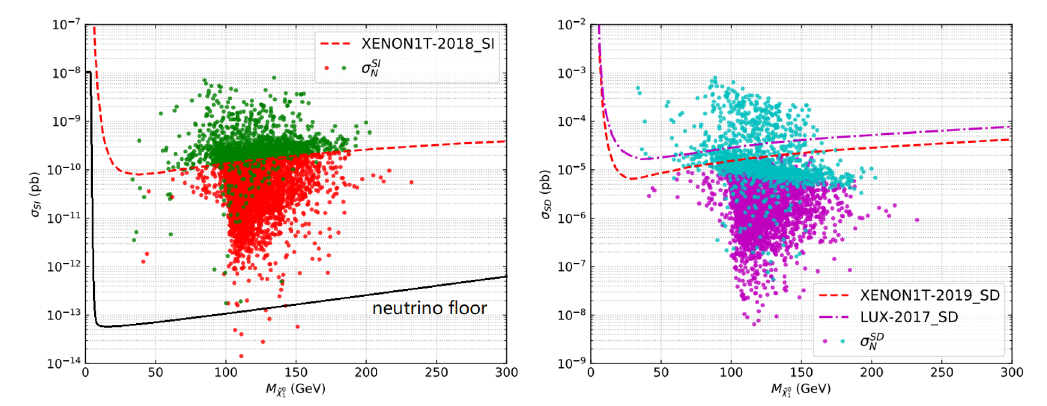
Figure 3 . SI (left plot) and SD (right plot) cross section for DM-nucleon experiments versus the mass of DM in the scenario with two mass-degenerate Higgs bosons. The red dashed line on the left plot stands for the XENON-1T SI limit in 2018, the red dashed line (magenta dash-dotted) on the right plot stands for the XENON-1T SD limit in 2019 (LUX SD limit in 2017). Samples above these lines are excluded, and samples with red and magenta points are the surviving samples considering the limits from DM direct detections. The black solid line stands for the neutrino floor.